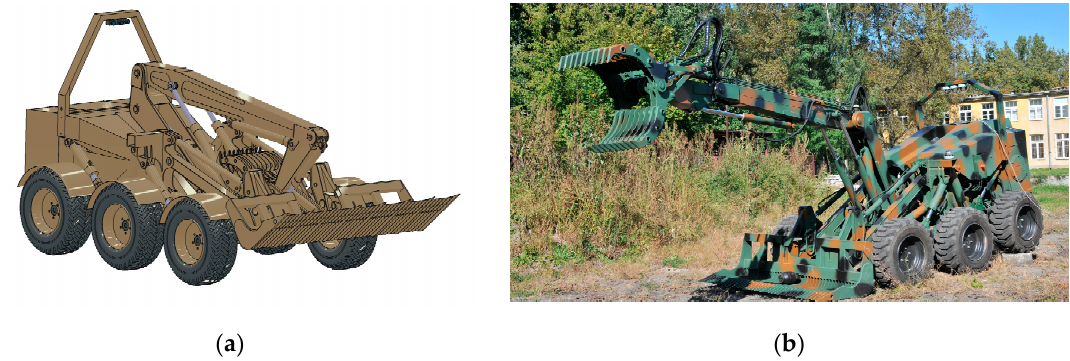
Figure 1. View of a 3D CAD model of the robot ( a ) and 6 × 6 robot ( b ).